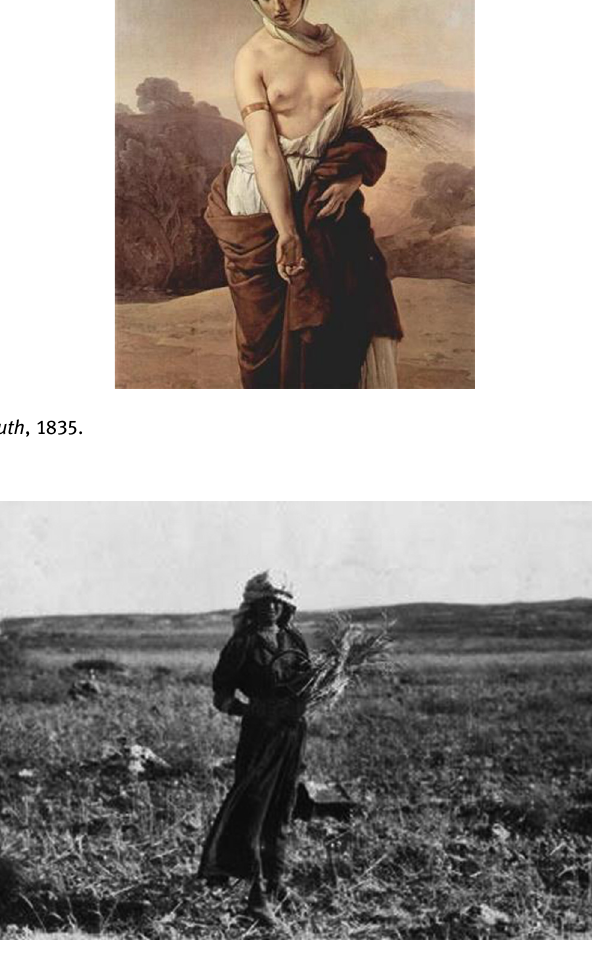
Figure 6: Khalil Raad, Ruth the Gleaner ,